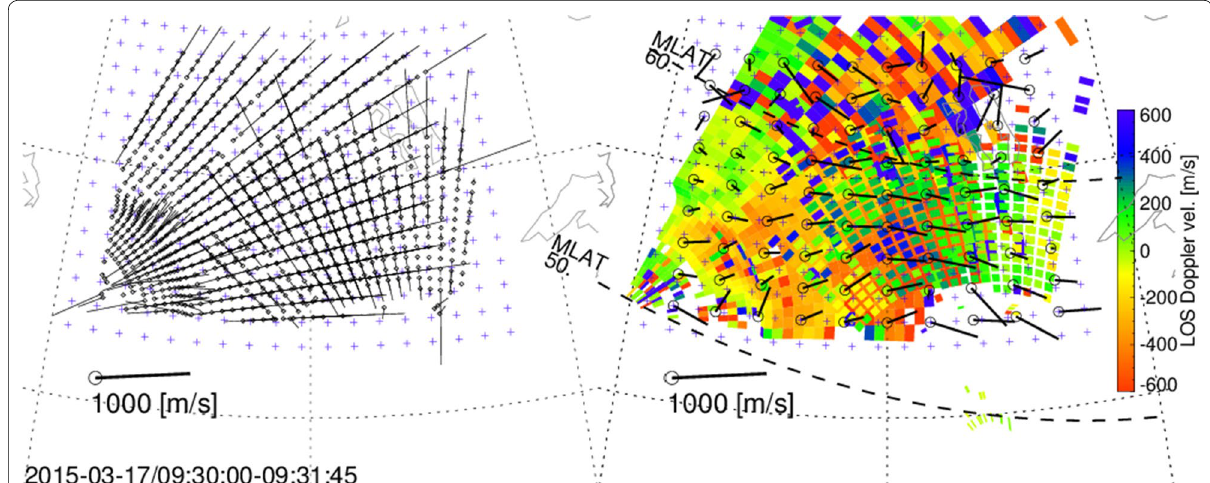
Fig. 12 (left) Raw LOSV vectors obtained by the CVE and FHW radars for 0930:00–09:31:45 UT. (right) Color‑coded LOSV values superimposed by the fitted velocity vectors resulting from the SECS reconstruction method. For both panels, the locations of SECS poles are denoted by blue